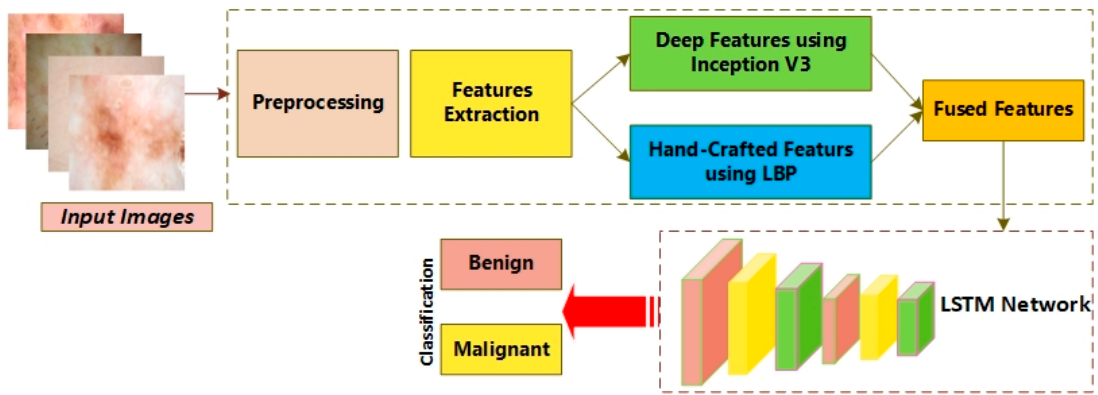
Figure 1. Architecture of the proposed skin cancer detector.